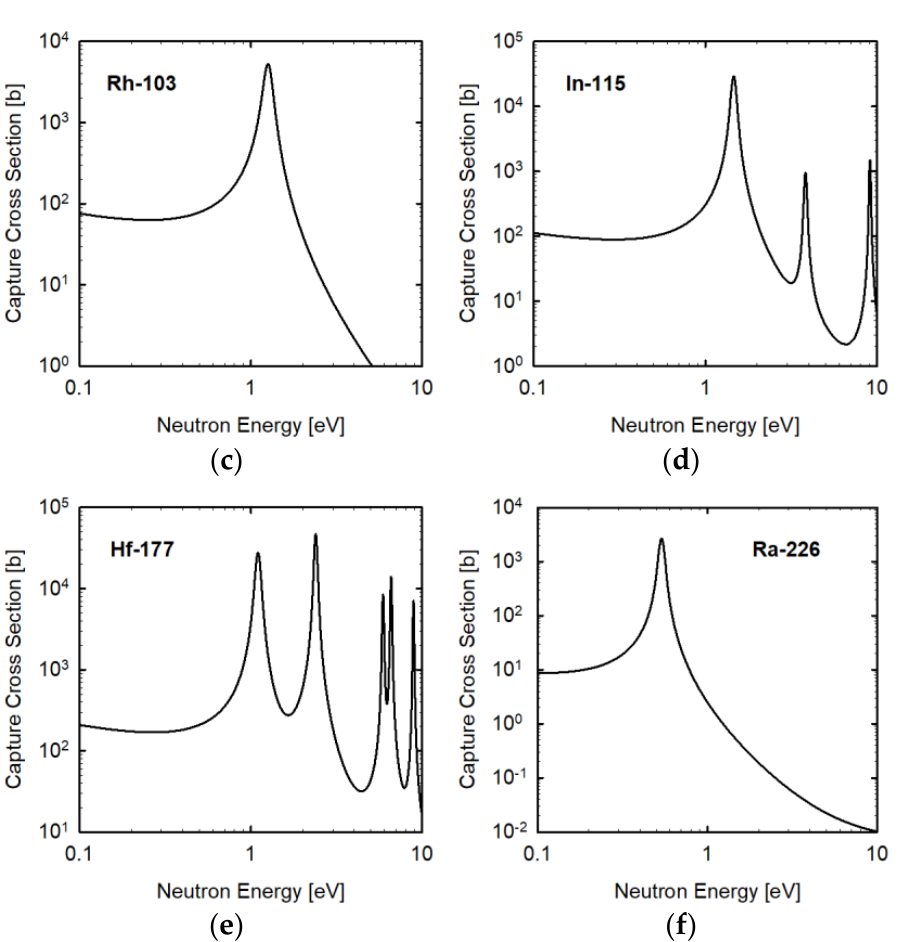
Figure 3. ( a ) Capture cross sections for 𝑇 𝑠 = 300 K of 197 Au; ( b ) 59 Co; ( c ) 103 Rh; ( d ) 115 In; ( e ) 177 Hf; ( f ) 226 Ra.